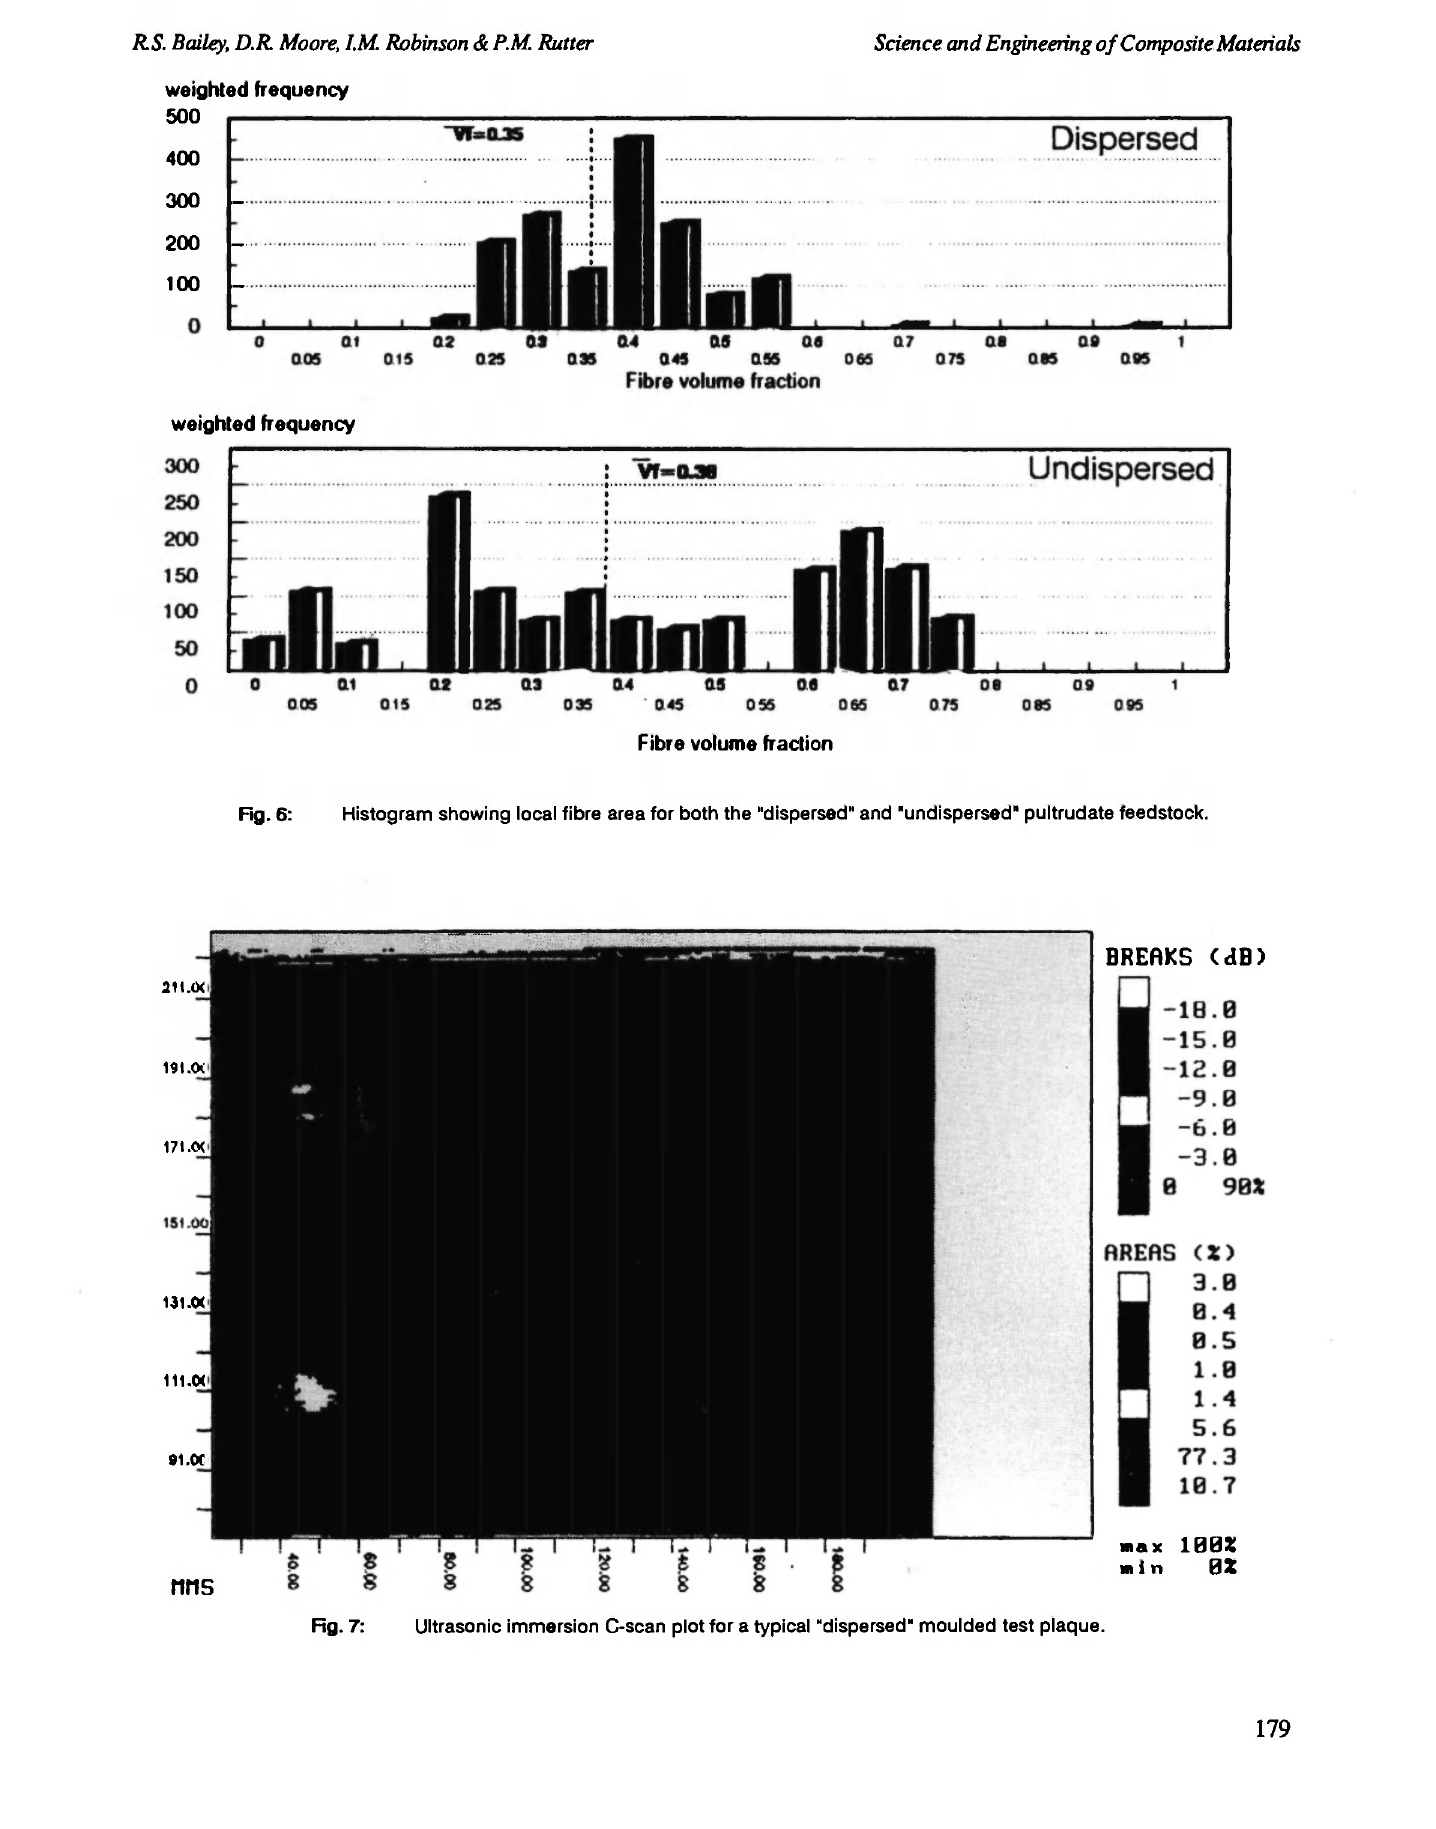
Fig. 7: Ultrasonic immersion C-scan plot for a typical "dispersed" moulded test